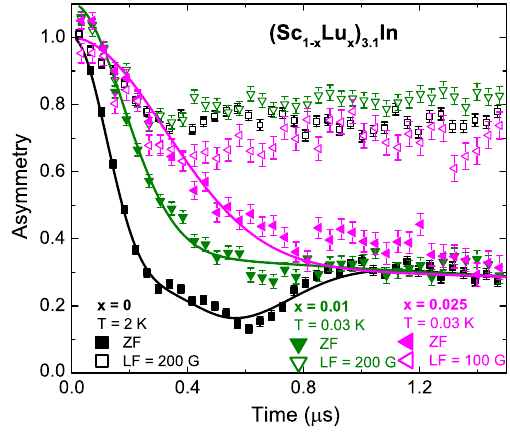
Þ Lu 3 . 1 In, x x